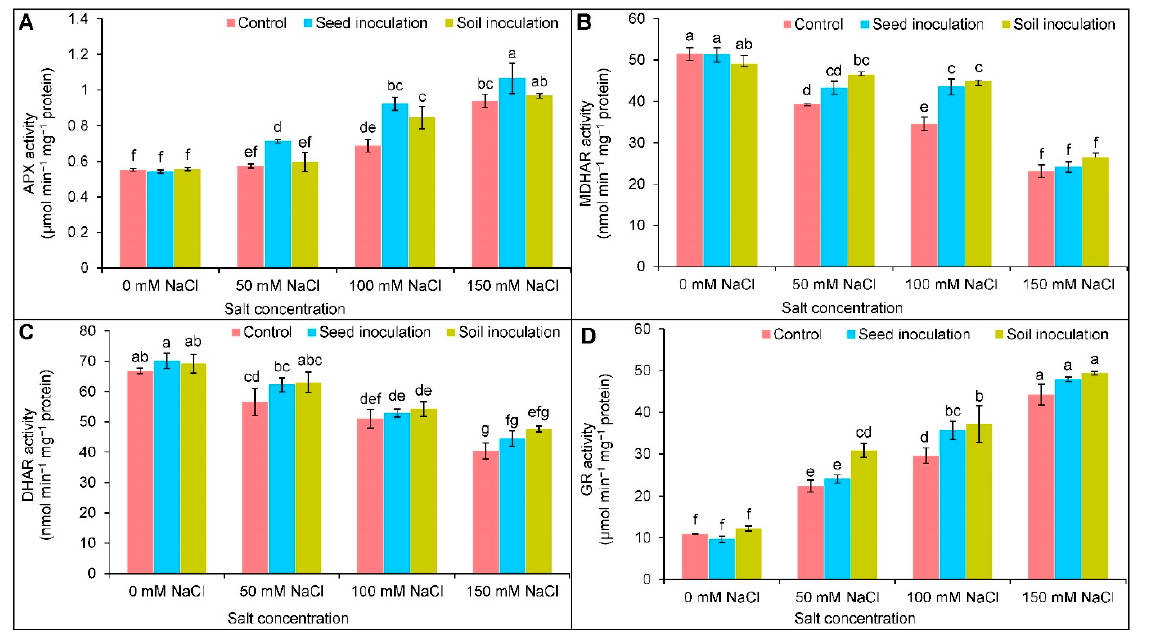
Figure 7. Effect of Bacillus subtilis in response to different concentrations of salt stress on the activities of APX ( A ), MDHAR ( B ), DHAR ( C ), and GR ( D ) of soybean ( Glycine max cv. BARI Soybean-5). Values in a column are mean ± SD. Different letters on each bar indicate significant differences among the treatment after applying a Tukey’s HSD test at p ≤ 0.05.